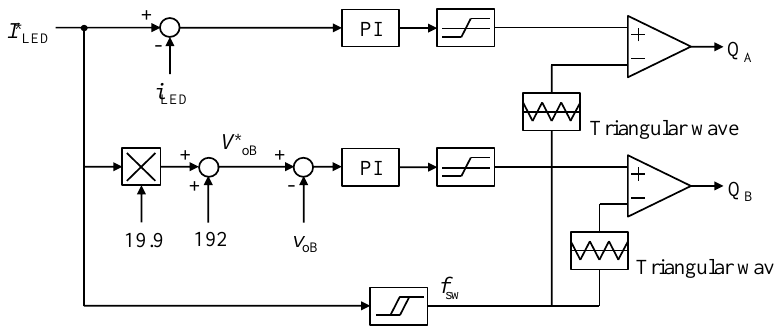
Figure 29. Control block of the proposed cooperative control method with variable switching frequency.